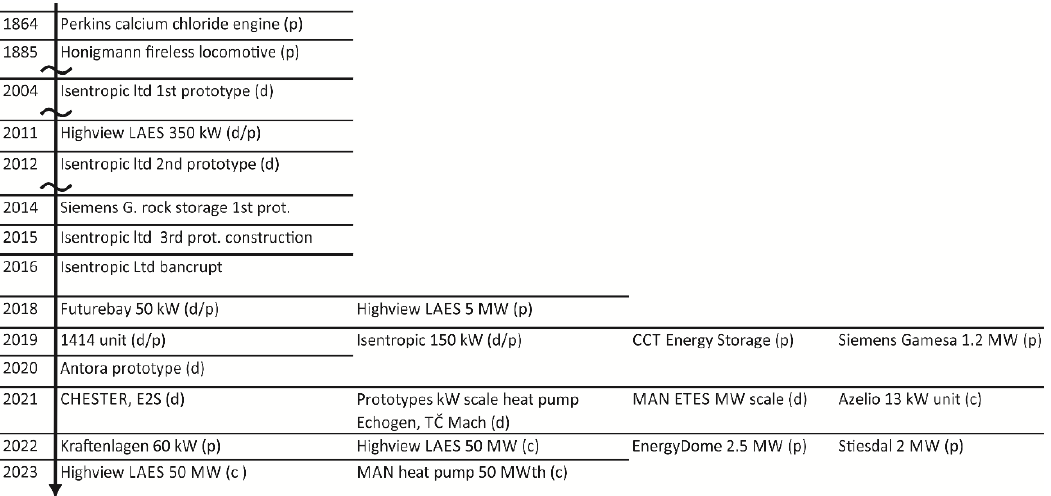
Figure 7. Timeline of experimental commercial CB development. In notation (d) stands for demo or laboratory prototype, (p) pilot, (c) commercial units.